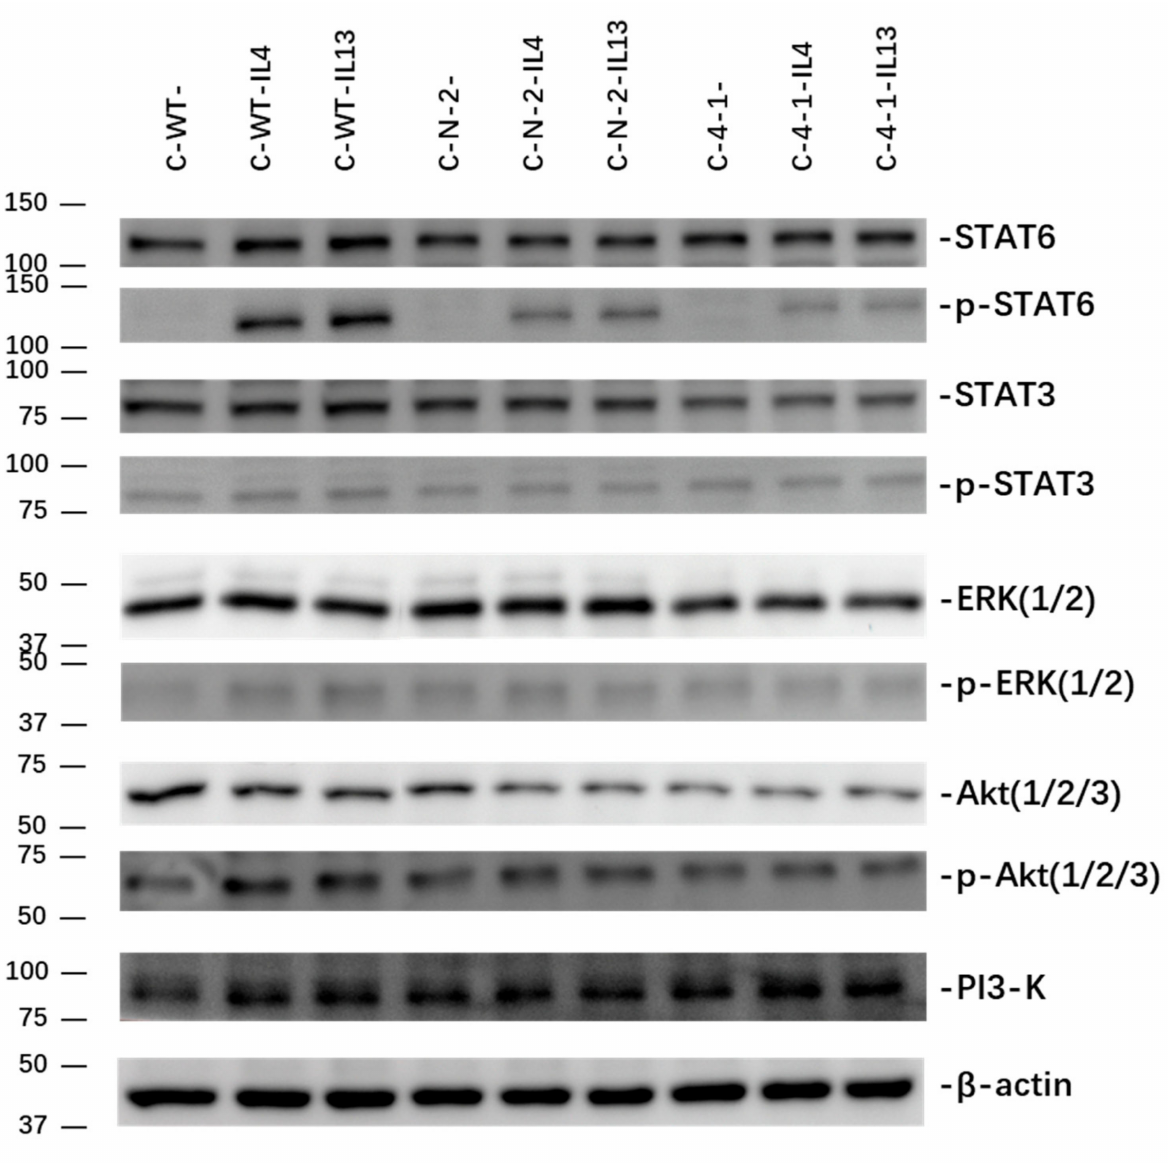
Figure 8. Basal and phosphorylated expression of STAT3, STAT6, ERK1/2 and Akt, and activation of PI3K in C-WT, C-N and C-KD clones. WB was performed to determine the expression of relevant pathway components in C-WT, C-N-2 and C-4-1. The phosphorylation of kinases and transcription factors was detected in cells treated with recombinant IL-4 (0.4 nM for 30 min) and IL-13 (1 nM for 30 min) in comparison to untreated cells (-). β -actin was used as loading control. Abbreviations: Akt: protein kinase B; ERK: extracellular signal-regulated kinase; IRS: insulin receptor substrate; PI3K: phosphoinositide 3-kinase; STAT: signal transducer and activator of